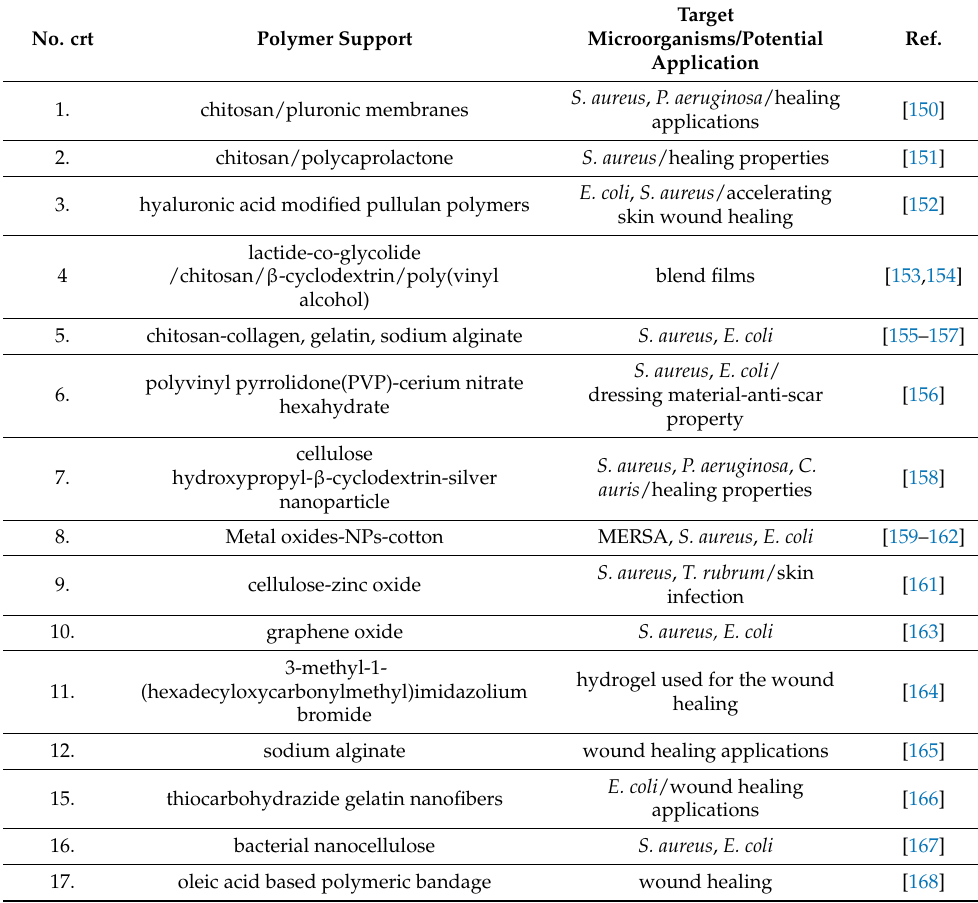
Table 2. Types of composite materials used as a support loaded with curcumin, used in bandages or